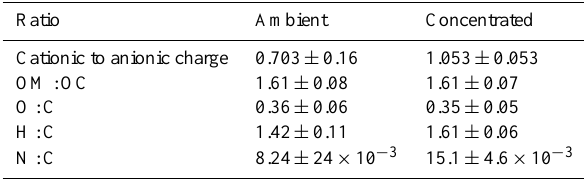
Table 3. Ratio of SP-AMS cationic to anionic charge and elemen- tal ratios for organics. Ambient and concentrated aerosol (aver- age ±